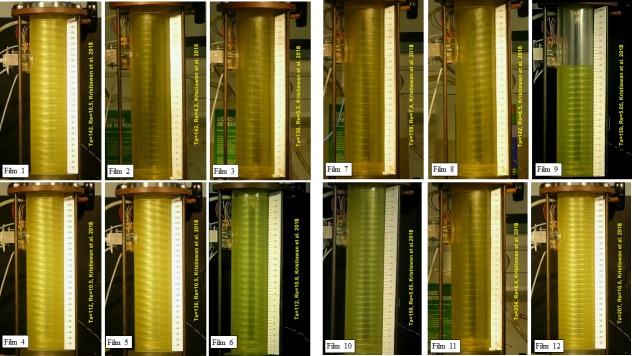
Snapshots of films acquired in the present investigation.For regime abbreviations see Fig 5. Film 1. TV, Ta = 142, Re = 10.5; Film 2. 1V, Ta = 142, Re = 4.2; Film 3. 1+1, Ta = 130, Re = 5.3; Film 4. 0+1, Ta = 112, Re = 10.5; Film 5. 0+2, Ta = 130, Re = 10.5;Film 6. 0+1, Ta = 112, Re = 10.8. Film 7. T+1, Ta = 159, Re = 7.4; Film 8. 0–2, Ta = 142, Re = 8.5; Film 9. 0–1, Ta = 159, Re = 5.05. Film 10. M-1, Ta = 159, Re = 5.05; Film 11. 4–1,Ta = 254, Re = 6.4; Film 12. 3V, Ta = 207, Re = 10.5.